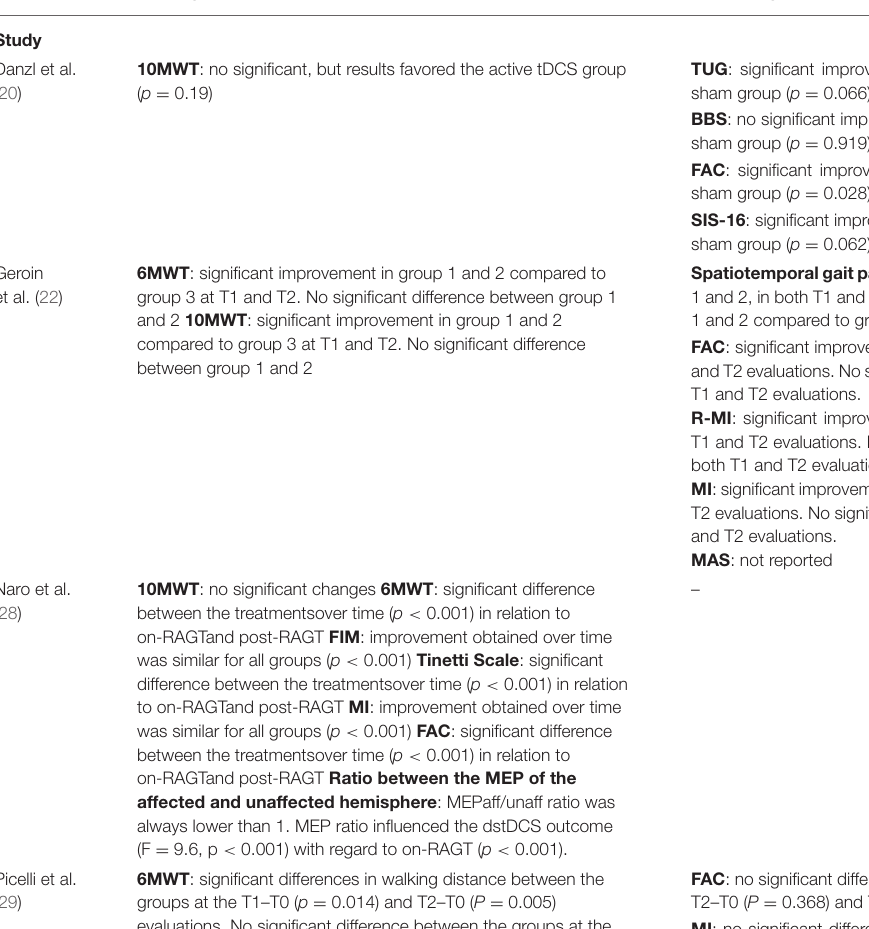
TABLE 5 | Results of the studies. Primary outcomes Secondary